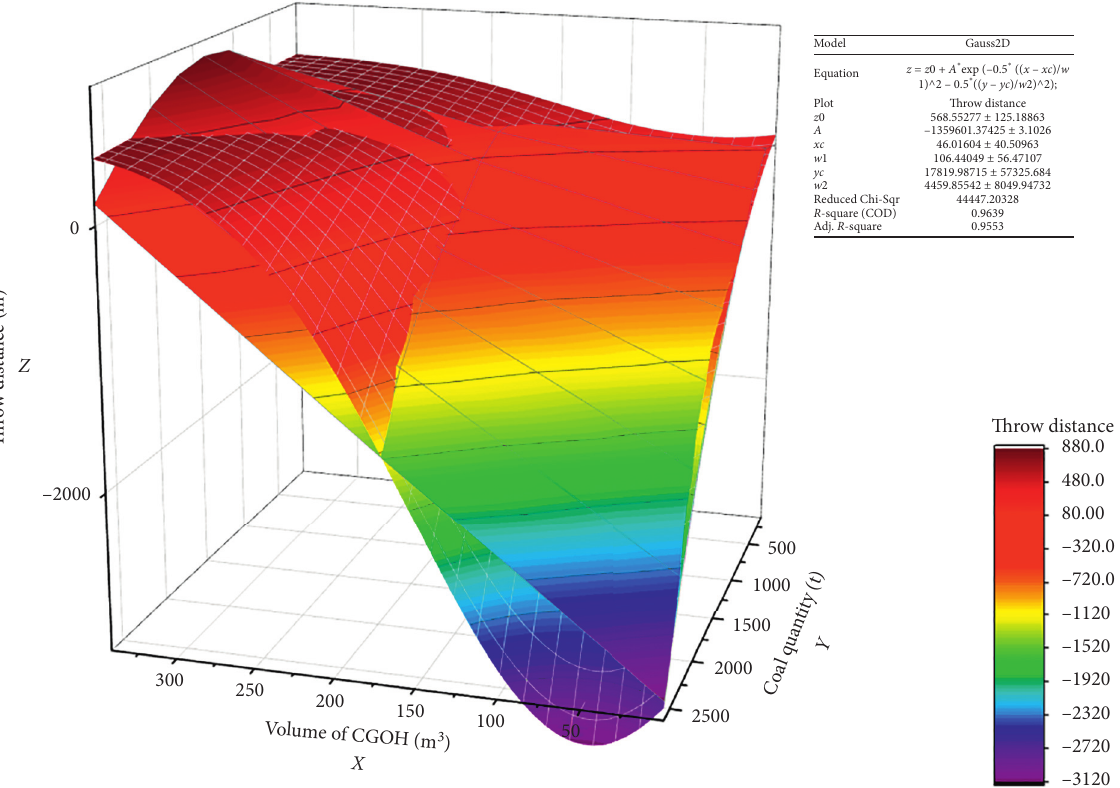
Figure 19: 3D color mapping surface of hole parameters and its nonlinear surface fit